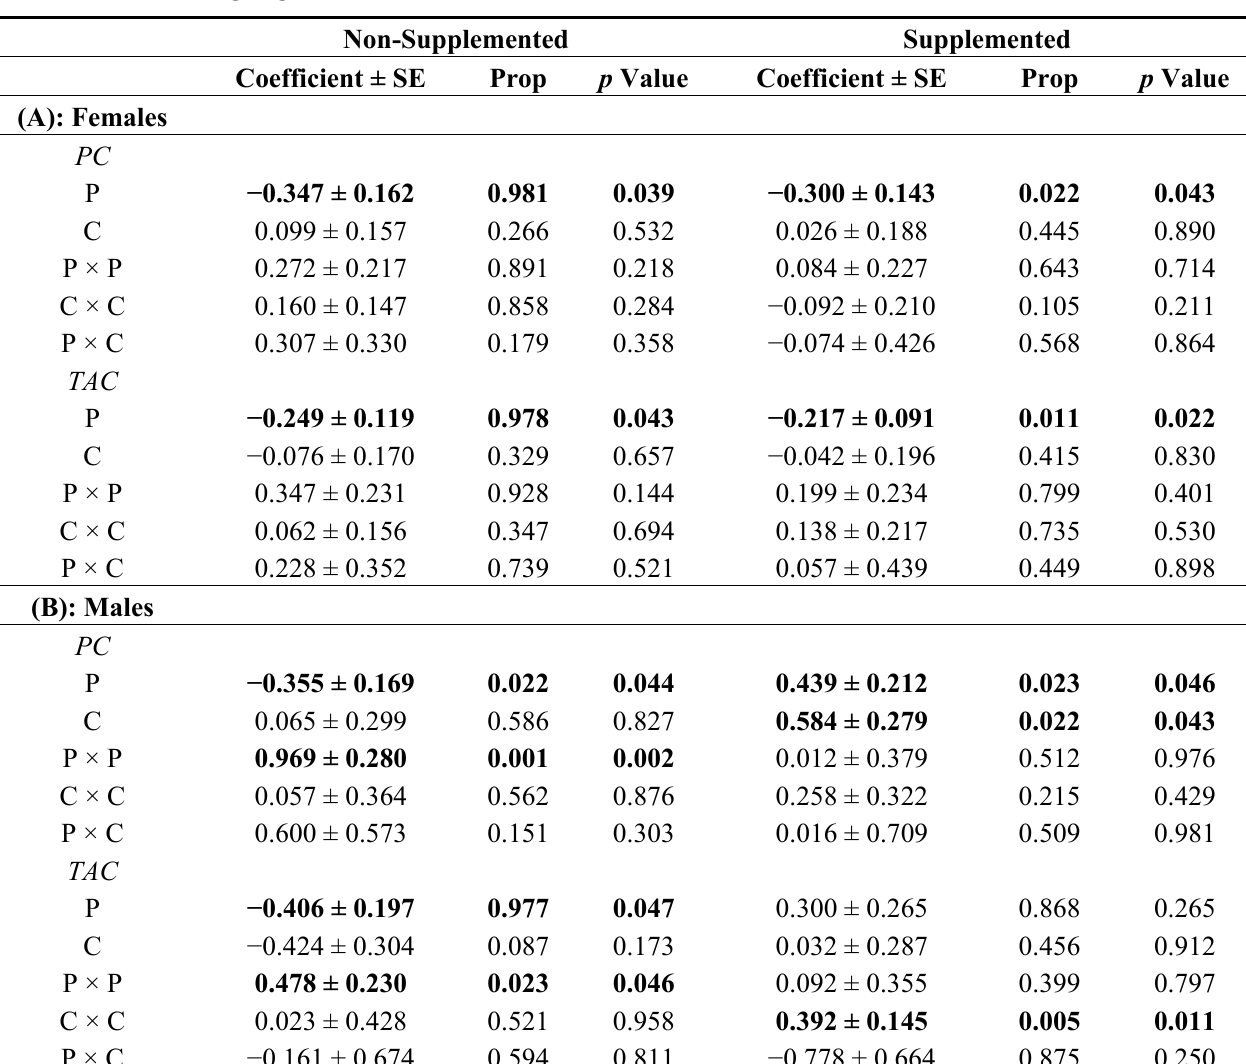
Table 2. The linear and nonlinear effects of daily protein (P) and carbohydrate (C) intake on the protein carbonylation (PC) and total antioxidant capacity (TAC) of ( A ) female and ( B ) male T. commodus with and without DL -alpha-tocopherol supplementation. Significant effects are highlighted in